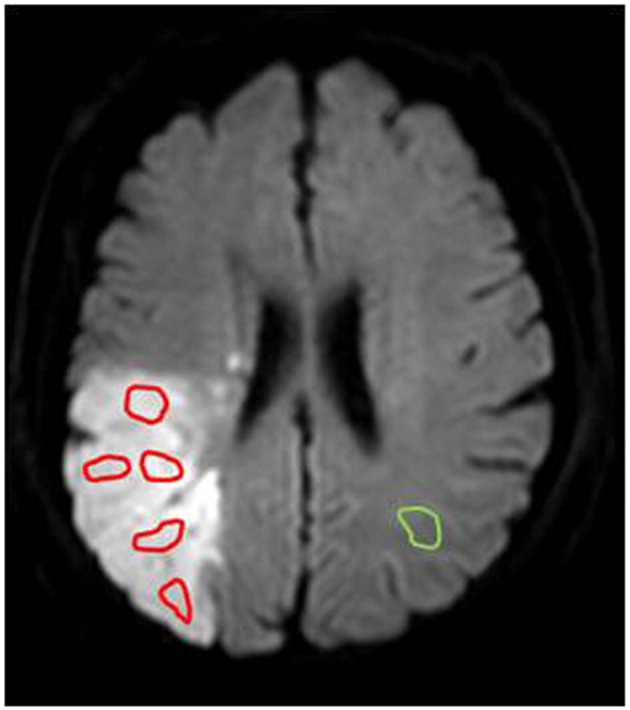
An example of the ROI selection for quantitative APTW image analysis on a DW image. Several ROIs (red, 100~125 pixels each) were selected within the infarcted lesion, and a ROI (green, 100~125 pixels) was selected within the CNAWM for comparison.